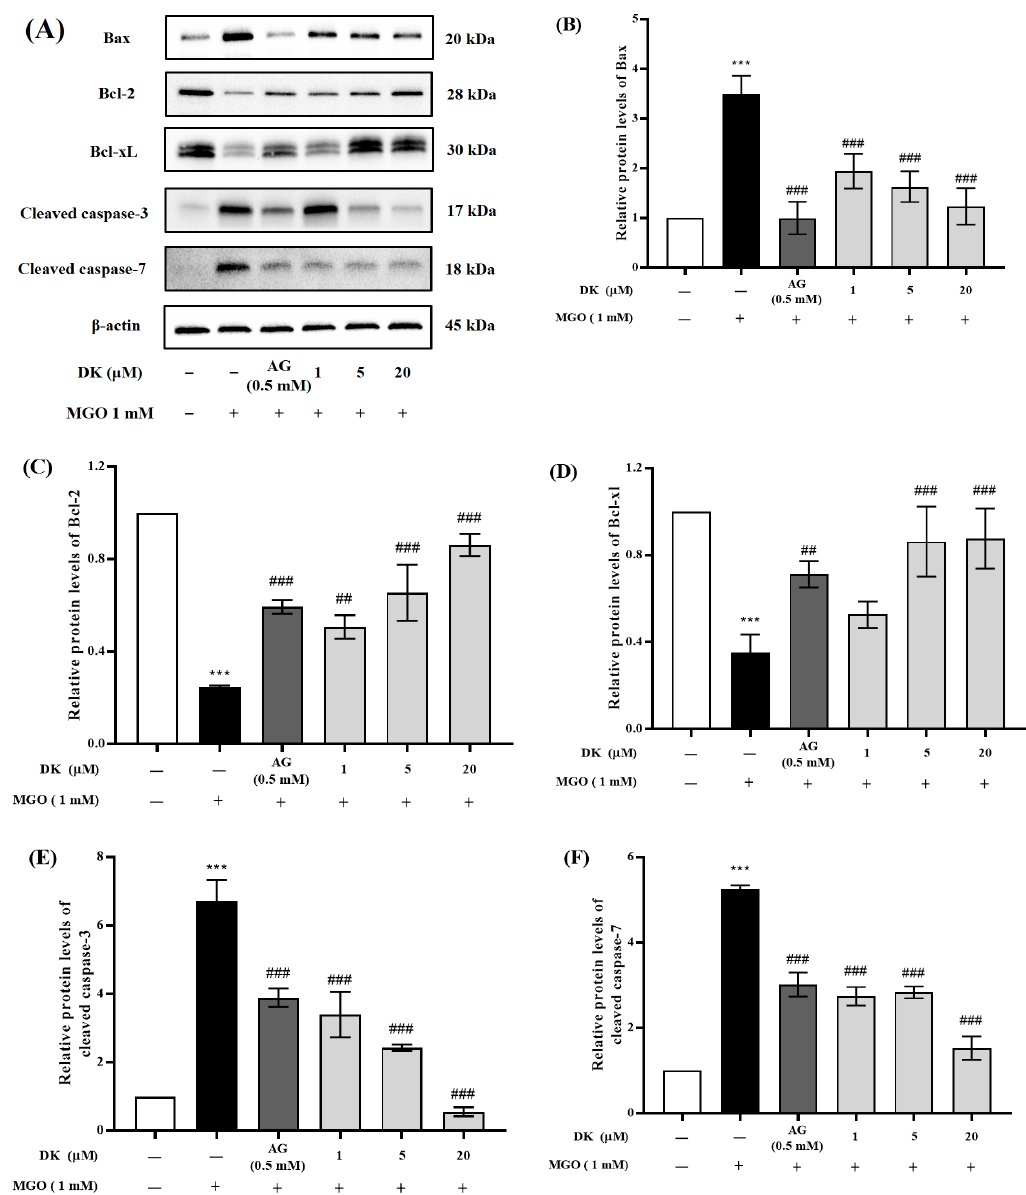
Figure 5. Preventive effect of DK on apoptosis-related protein expression in mouse glomerular mesangial cells. Cells were pretreated with DK (1, 5, and 20 µ M) or AG (0.5 mM) for 1 h. Then, 1 mM MGO was added and incubated for 23 h. ( A ) The protein expression levels of antiapoptotic (Bcl-1 and Bcl-xL), proapoptotic (Bax), cleaved caspase-3, and cleaved caspase-7 were measured by Western blotting; ( B – F ) The bar graph demonstrates the relative protein expression band intensity level of Bax, Bcl-2, Bcl-xL, cleaved caspase-3, and cleaved caspase-7. All data are presented as mean ± standard deviation ( n = 3) (*** p < 0.001 vs. nontreated cells and ## p < 0.01, ### p < 0.001 vs. MGO-treated